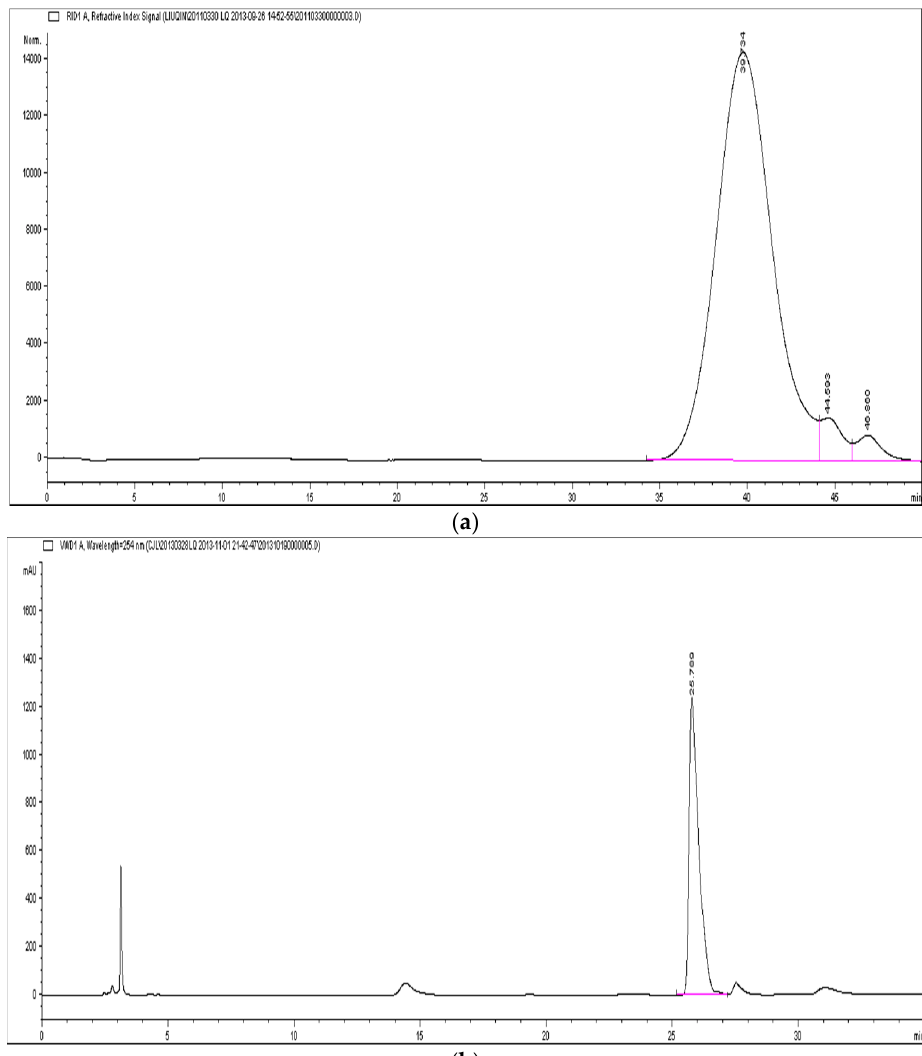
Figure 1. HPGPC (high gel performance chromatography) profile and HPLC (high performance liquid chromatography) profile of polysaccharide H-1-2: ( a ) the chromatogram of H-1-2 by HPGPC analysis; and ( b ) the chromatogram of monosaccharide composition of H-1-2 by HPLC analysis.